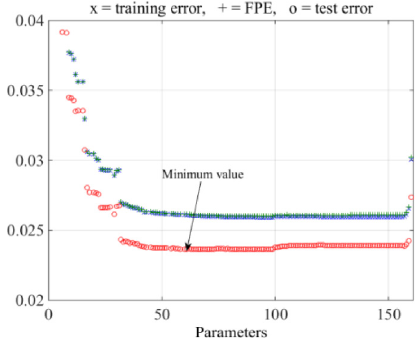
Fig. 2. Best number of parameters by Akaike